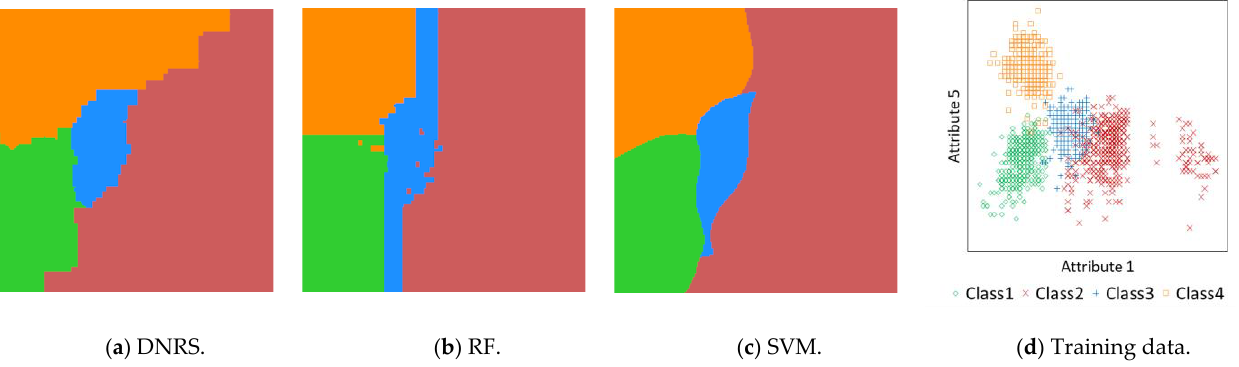
Figure 7. Visualized classification results in a two-dimension feature space using one of the 10-fold cross-validation datasets of attributes 1 and 5 in the Wireless dataset. cross-validation datasets of attributes 1 and 5 in the Wireless